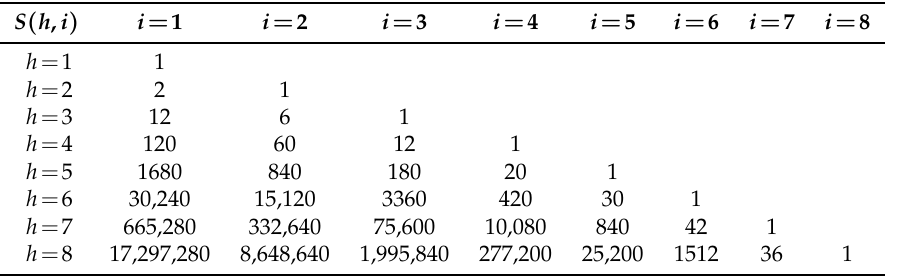
Table 1. Values of S ( k , i )